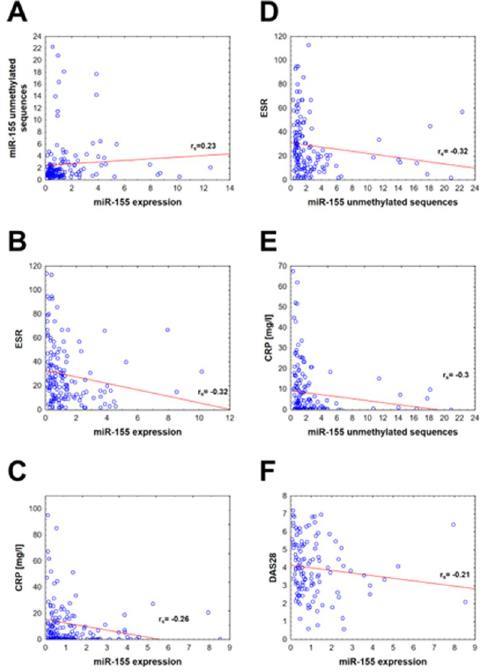
Fig 3. Spearman’s rank correlation between studied parameters. All presented variables are statistically significant with the p-value < 0.05. Diagrams from A to F show correlations between two variables and the following correlation coefficients (r s ): A: correlation between miR-155 unmethylated sequences and miR-155 expression, r s = 0,23; B: correlation between ESR and miR-155 expression, r s = -0,32; C: correlation between CRP and miR-155 expression, r s = -0,26; D: correlation between ESR and miR-155 unmethylated sequences, r s = -0,32; E: correlation between CRP and miR-155 unmethylated sequences, r s = -0,3; F: correlation between DAS28 and miR-155 expression, r s = -0.21.